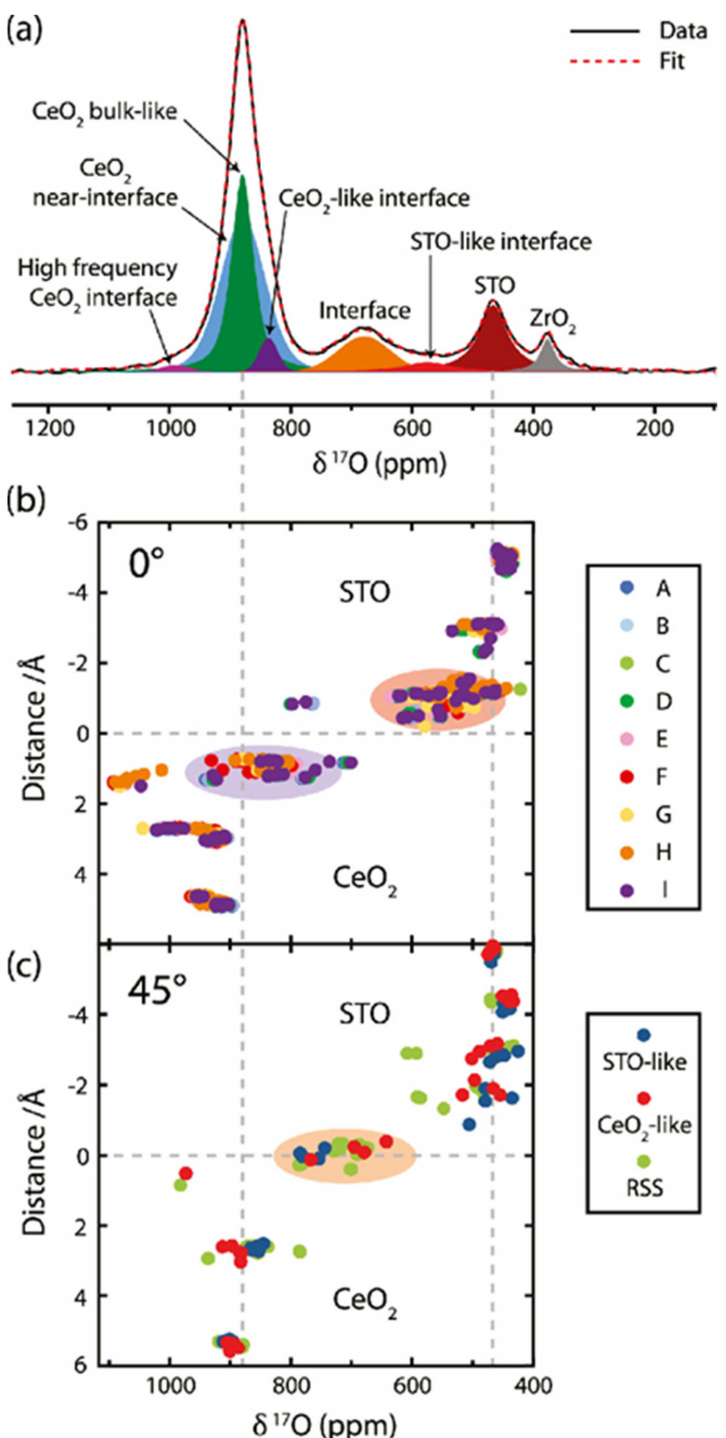
Figure 2. ( a ) 17 O NMR spectrum for CeO 2 -SrTiO 3 nanopillar lift-off isotopically enriched films. ( b , c ) DFT-calculated isotopic chemical shifts as a function of distance from the interface of different interfacial structures. Three structure interfaces of the simple model and a low-energy structure were found from random structure searching in 0 ◦ interface ( b ) and 45 ◦ interface ( c ). Reproduced